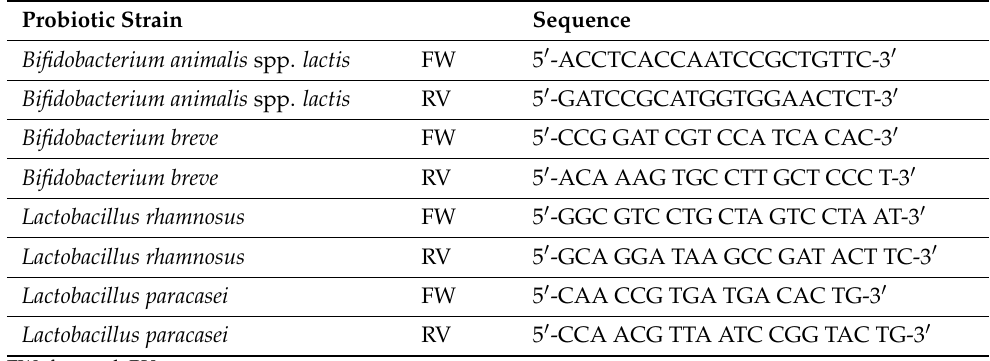
Table 2. Primer sequences used in the RT-qPCR assay for the detection and quantification of probiotic strains in food supplement